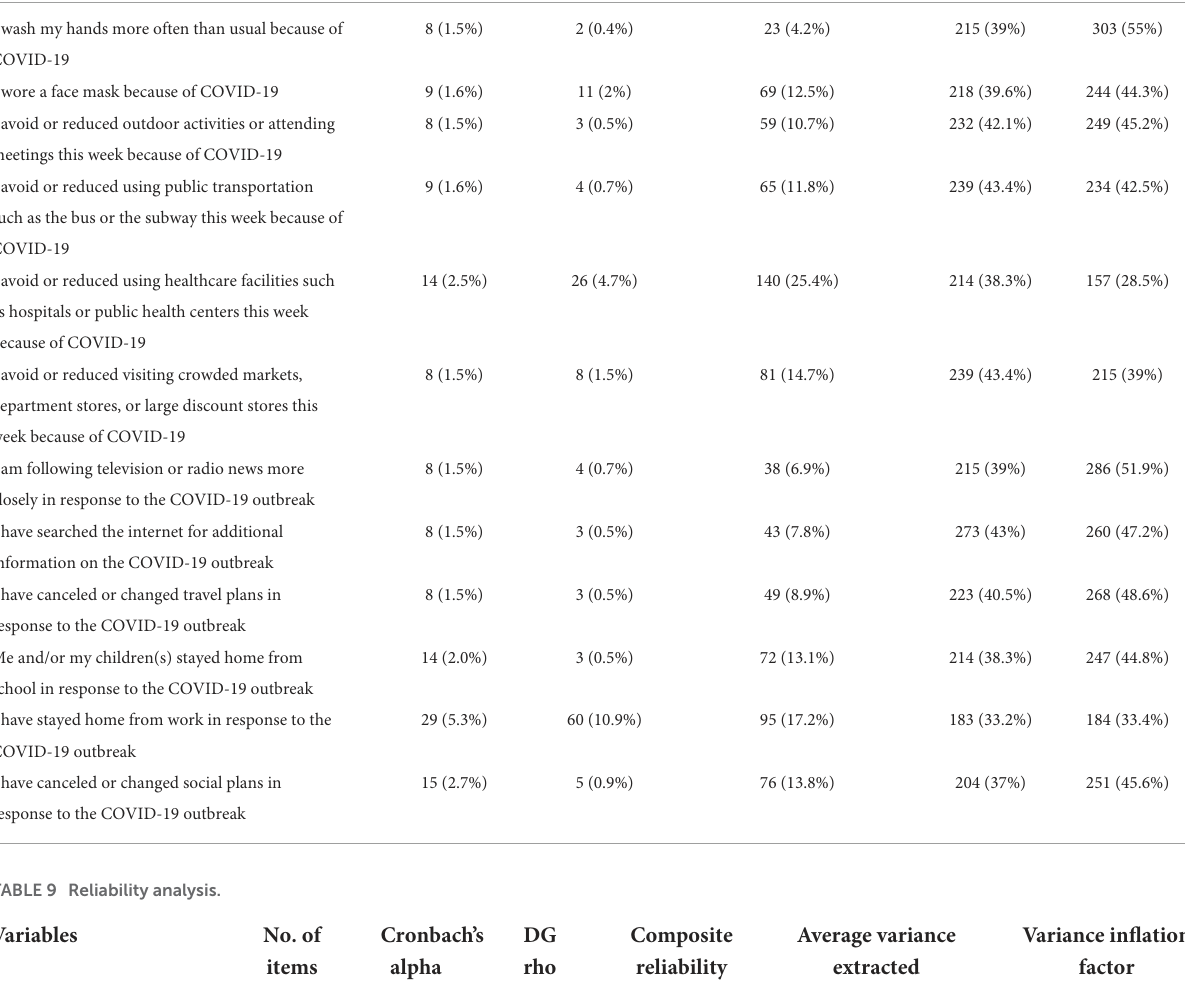
TABLE 8 Engagement in precautionary activities—preventive behavior. Strongly disagree Disagree